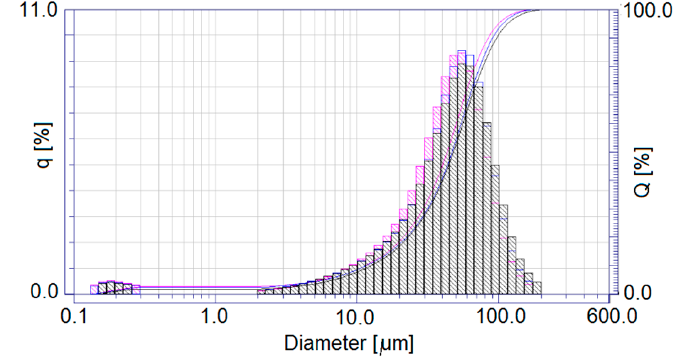
Figure 3. Particle size distribution curves for sanitary ceramic aggregates ( q is the relative content [%]; Q is the cumulative content [%]).